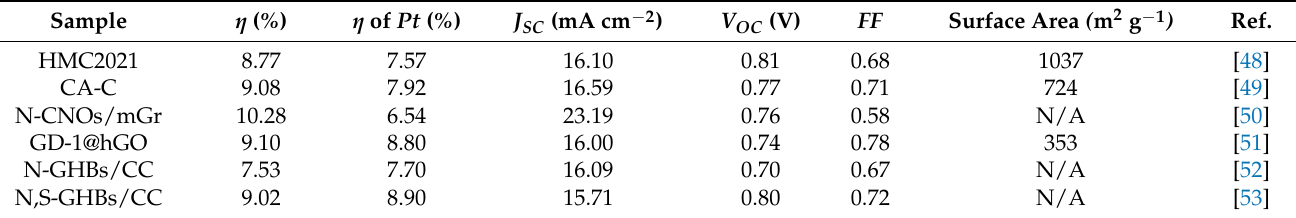
Figure 4. ( a ) Molecular equation of the additional reaction and the effect of the R/F molar ratios on the CA particles [49]. ( b ) Scheme of the CVD design for the growth of N-GHBs; three types of the N-doped states in N-GHBs include pyridinic N, pyrrolic N, and quaternary N [52]. ( c ) Scheme shows the growth of GHBs on CC in a CVD reactor at 1090 °C and the temperature profile inside the quartz tube of the CVD system [53]. 2.2. Conductive Polymer Electro-Catalysts Due to the flexible properties, good electrical conductivity, good adhesion to the sub- strates, and easy integration with roll-to-roll processes [31,54–56], several conductive pol- ymer electro-catalysts such as PEDOT:PSS, PEDOT-MeOH, cPEDOT, PEDOT, PProDOT, PANI, and PPy are used in DSSCs. In this section, the PEDOT, cPEDOT, and PPPy (Figure 5) are chosen for further discussion because they have been demonstrated to perform well in various redox couples (Cu 2+ /Cu + and I − /I 3 − ), dyes (Y123, D35/ XY1, XY1b/Y123, D149,